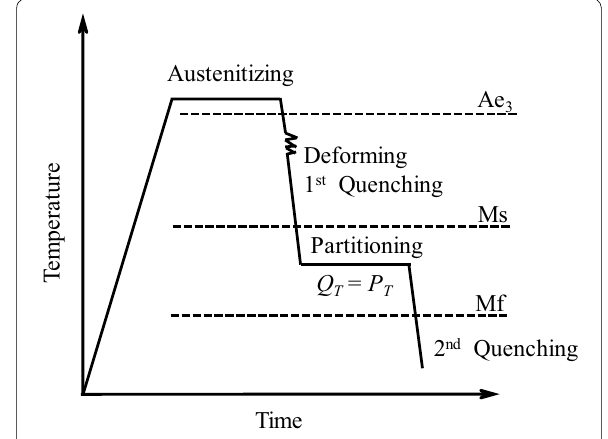
Figure 1 Schematic illustration of the one-step Q&P hot stamping